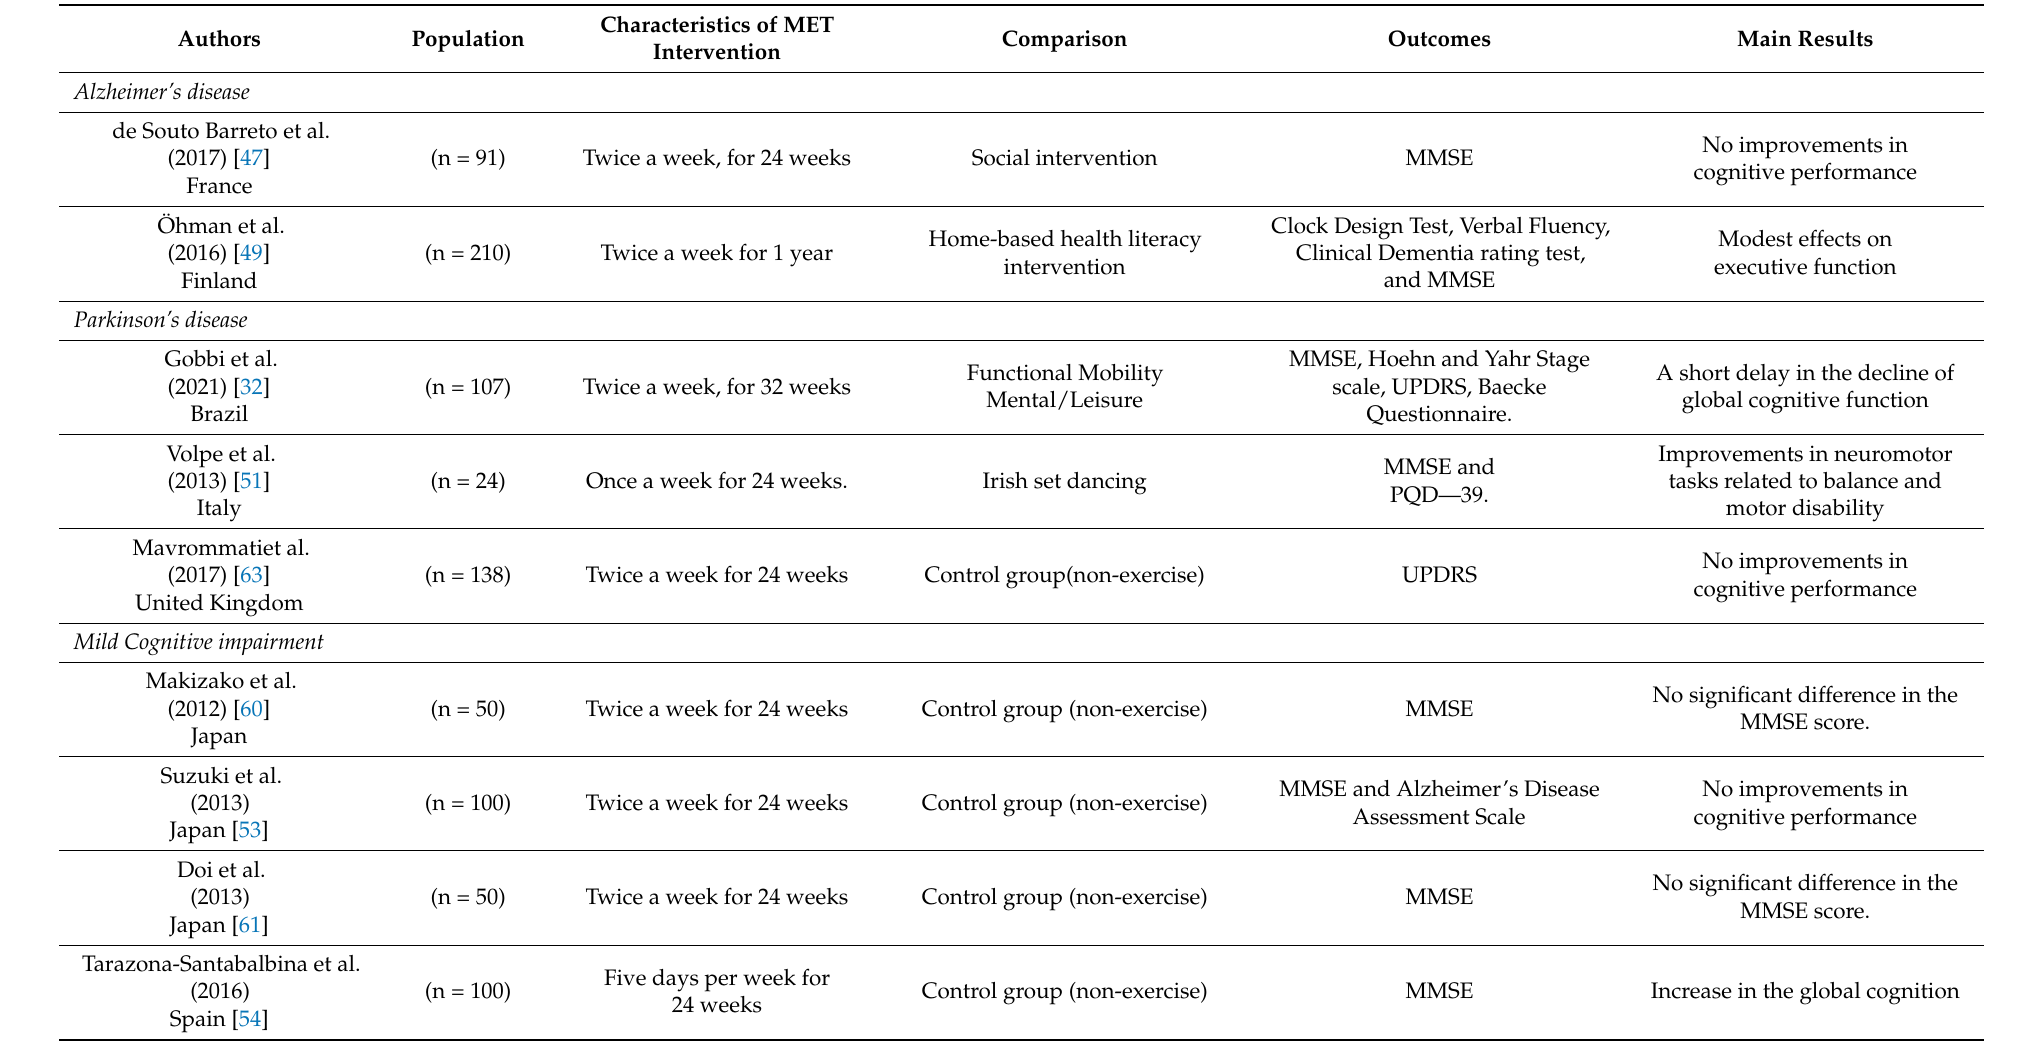
Table 3. Characterization of the studies included in the review, according to PICOS